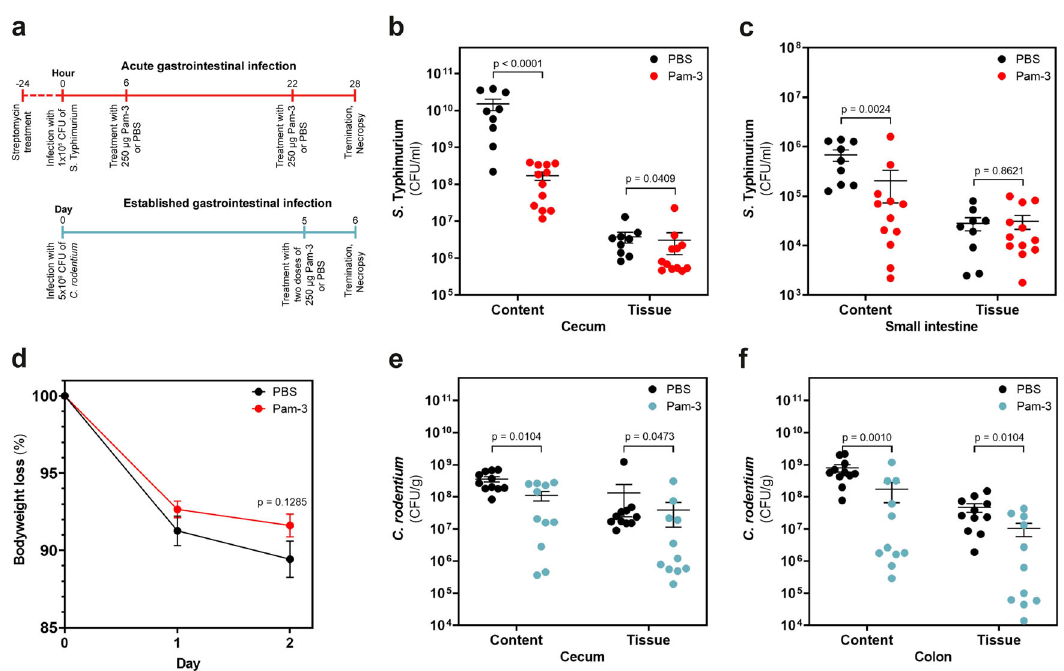
Fig. 6 Oral application of Pam-3 combats acute and established infections of S . Typhimurium and C. rodentium . a Overview of experimental setup. Mice were infected with S . Typhimurium (red circles) and treated orally with either 250 µ g Pam-3 ( N = 12) or PBS ( N = 9) after 6 h and 22 h post infection. Mice were infected with C. rodentium (blue circles) and treated orally with either 250 µ g Pam-3 ( N = 11) or PBS ( N = 11) after 5 days post infection. b CFU/ml of S . Typhimurium in cecum content and tissue. c CFU/ml of S . Typhimurium in small intestine content and tissue. d Body weight change during acute S . Typhimurium infection. e CFU/g of C. rodentium in cecum content and tissue. f CFU/g of C. rodentium in colon content and tissue. Results are expressed as the number of viable bacteria (in log 10 CFU) in the lumen and tissue and presented as mean ± SEM of biologically independent animals. Statistics were evaluated by using the Mann – Whitney